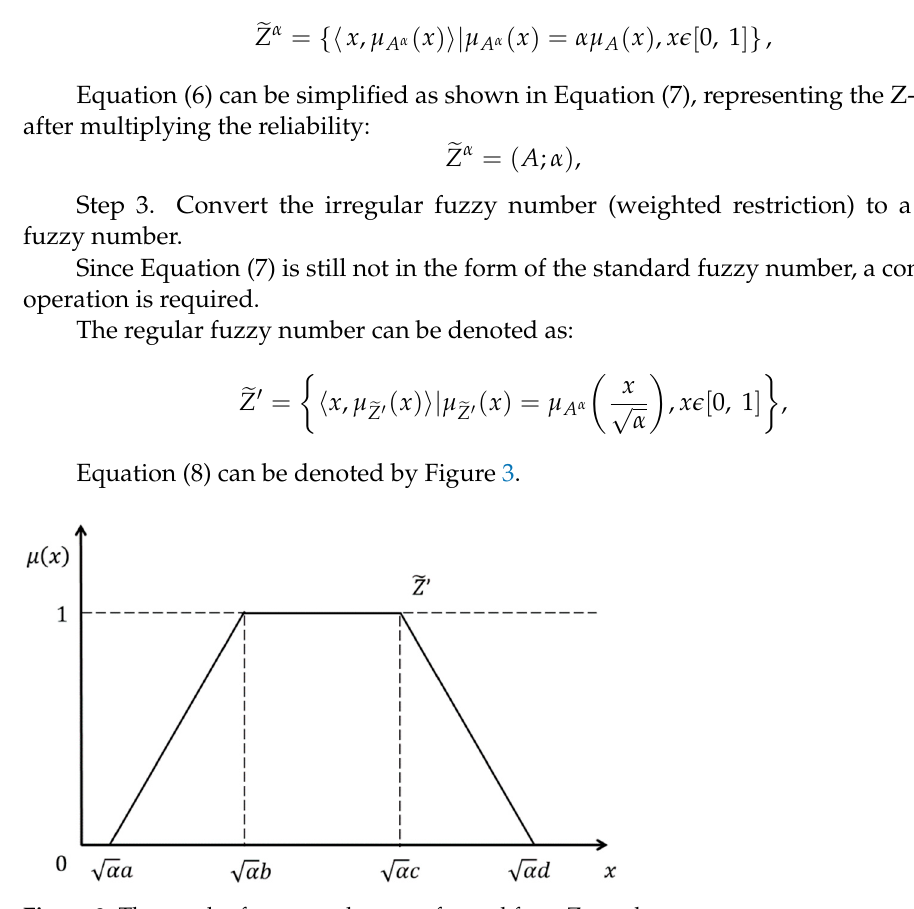
Figure 3. The regular fuzzy number transformed from Z-number.